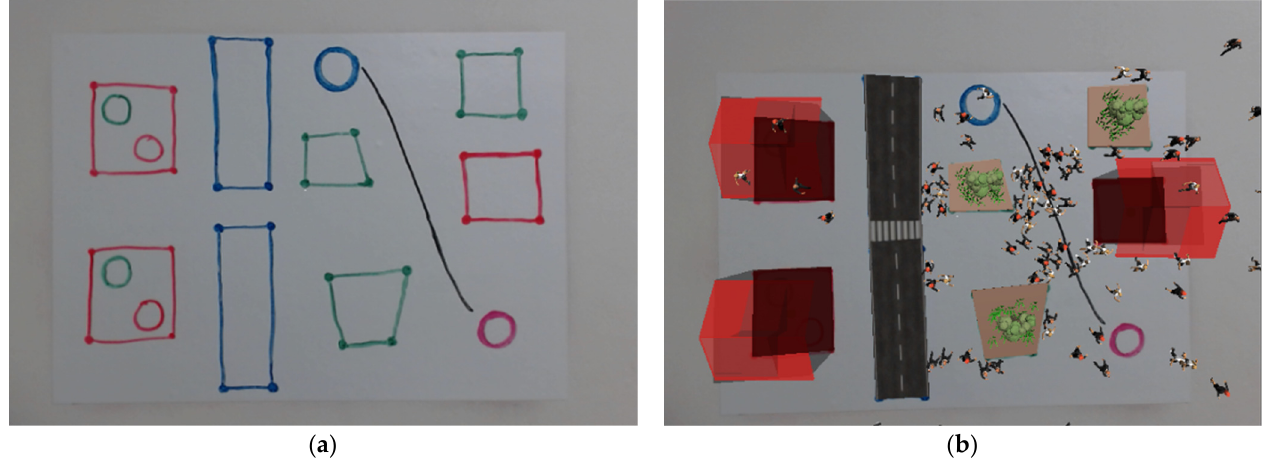
Figure 1. ( a ) Hand-drawn sketches of the users; ( b ) Project-based visualization of virtual environment where crowds are behaving based on the different environmental factors.